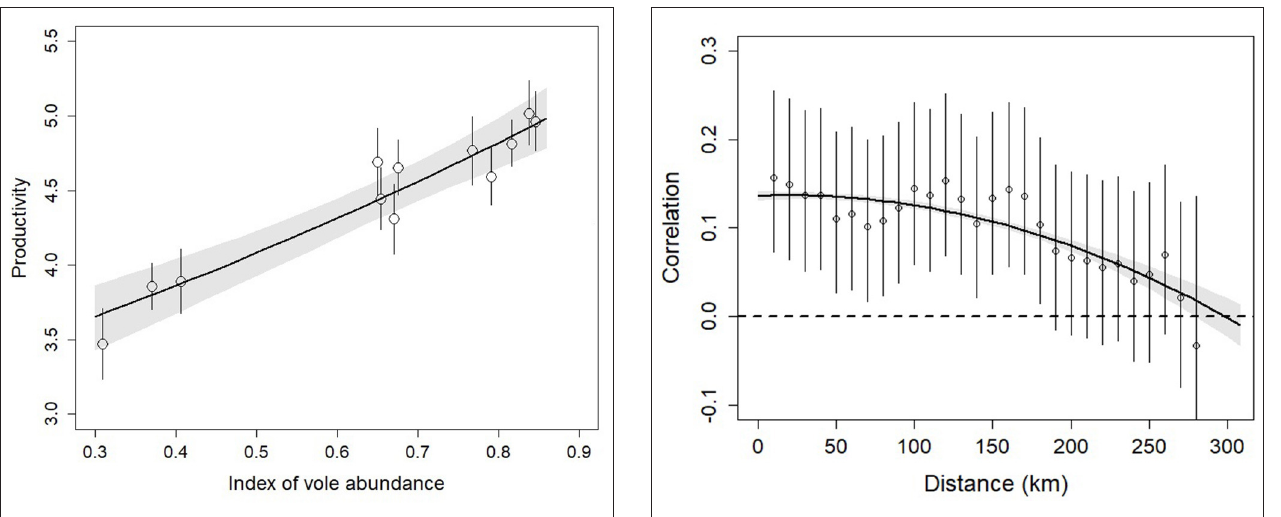
FIGURE 3 | Correlation in kestrel productivity against distance between pairs FIGURE 2 | Relationship between the index of vole abundance and of nest-boxes. Open circles show the correlation estimated by 10km distance productivity of kestrels from 2007 to 2018. Open circles show productivity classes. Distances from 280 to 310km were pooled into a single class due to estimates obtained from a model with a fixed time effect and the bold line sample size. The bold line shows the correlation in kestrel productivity shows the productivity estimates based on a linear function of the index of vole estimates based on a quadratic function of the distance between pairs of abundance. Vertical line and the shaded area show ± 95% CRI. nest-boxes. Vertical lines and the shaded areas show ± 95% TABLE 1 | Parameters estimates of the regression of the correlation in kestrel productivity against distance between pairs of nest-boxes. Parameter Mean [95% CRI] P ( β ) > 0 Linear relationship